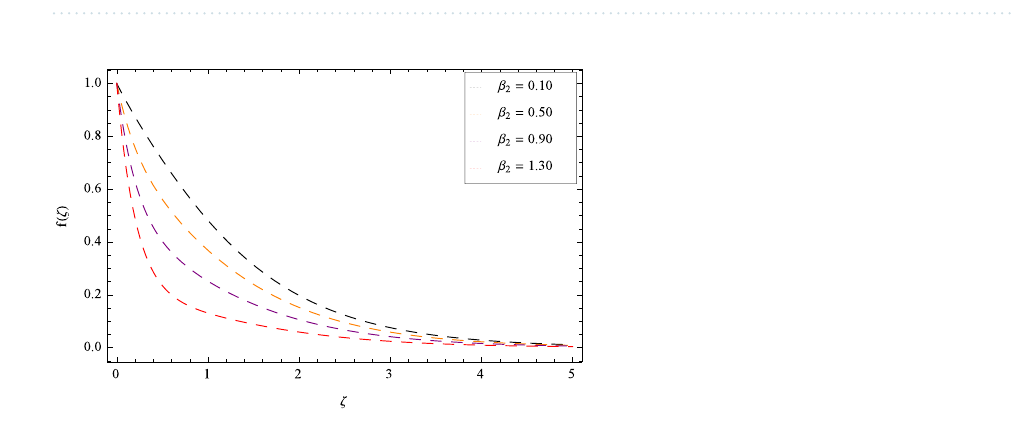
Figure 3. Pattern of graph curves on account of β 2 .